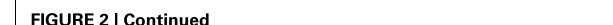
FIGURE 2 | Continued UPR pathways in eukaryotes. Accumulation of unfolded proteins inside the ER lumen triggers to UPR that, during the first layer of response, leads the cell to adaptation. IRE1 is the only identified ER stress sensor in yeast and it is widely conserved in metazoan and plants. Moreover, additional ER stress sensors so far identified are bZIP28 and AGB1 in plants, and ATF6 and PERK1 in metazoan. Activation of PERK leads to phosphorylation of two proteins: Nrf2 that activates the transcription of genes involved in redox homeostasis; and eIF2 α that decreases the overload of newly synthetized proteins into the ER and increases the specific translation of the transcription factor ATF4. Subsequently, ATF4 induces the expression of genes involved in amino acid metabolism, anti-oxidative stress response, folding, quality control and autophagy.The activation of IRE1 leads (1) to the selective degradation of mRNAs (RIDD) encoding ER-translocating proteins, decreasing the protein loading into the ER, and (2) to the translation of the bZIP transcription factors Xbp1/bZIP60/Hac1 mRNA in metazoan, plants and yeast, respectively, that upregulate the UPR target genes mainly involved in folding, quality control and autophagy. ATF6 in metazoans and bZIP28 in Arabidopsis are translocated into the Golgi apparatus and cleaved by Site1 and Site2 proteases, releasing the ATF6/bZIP28 transcription factors domain, which then translocates to the nucleus where it increases the expression of genes involved in folding, quality control and autophagy. Upon excessive and prolonged ER stress, all the UPR pathways lead to cell death in yeast, metazoan, and plants. In plants, the cell death executioners are still largely unknown, while in metazoan they have been partially defined. In detail, IRE1 regulates the cell death through the mRNA decay of UPR target genes and of anti-apoptotic protein (anti-Casp2). In addition, IRE1 interacting withTRAF2 triggers the ASK1/JNK pathway promoting apoptosis. Moreover, PERK/eIF2 α /ATF4, IRE1, and ATF6 induce the expression of the transcription factor CHOP, involved in the induction of apoptosis. Blue, eukaryotes; black, metazoan; green, plants; pink, yeast. Figure adapted from Chen and Brandizzi